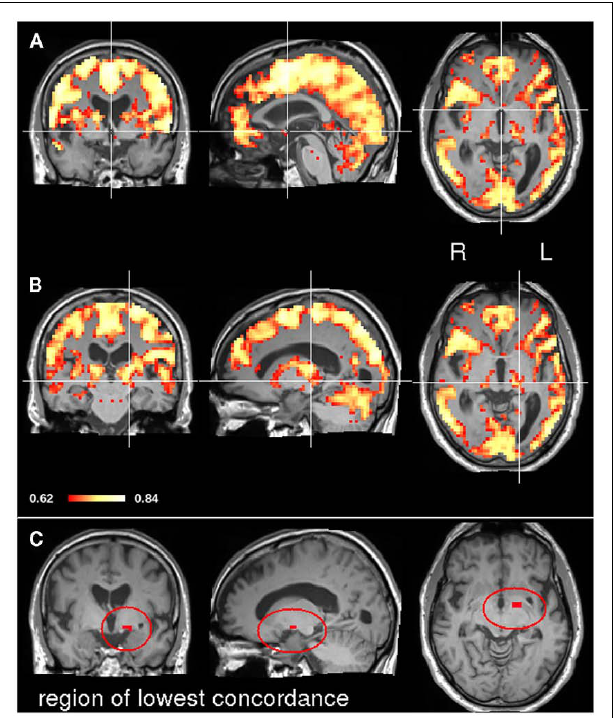
FIGURE 5 | CCM in a stroke patient. The concordance over all four time points (t1, t2, t3, and t4) was assessed.The top image (A) shows the CCM map at MNI slice position (0, 0, 0). In the middle image (B) the map crosshair marks the position of the left thalamic lesion.The bottom image (C) shows the region where connectivity concordance was lowest.